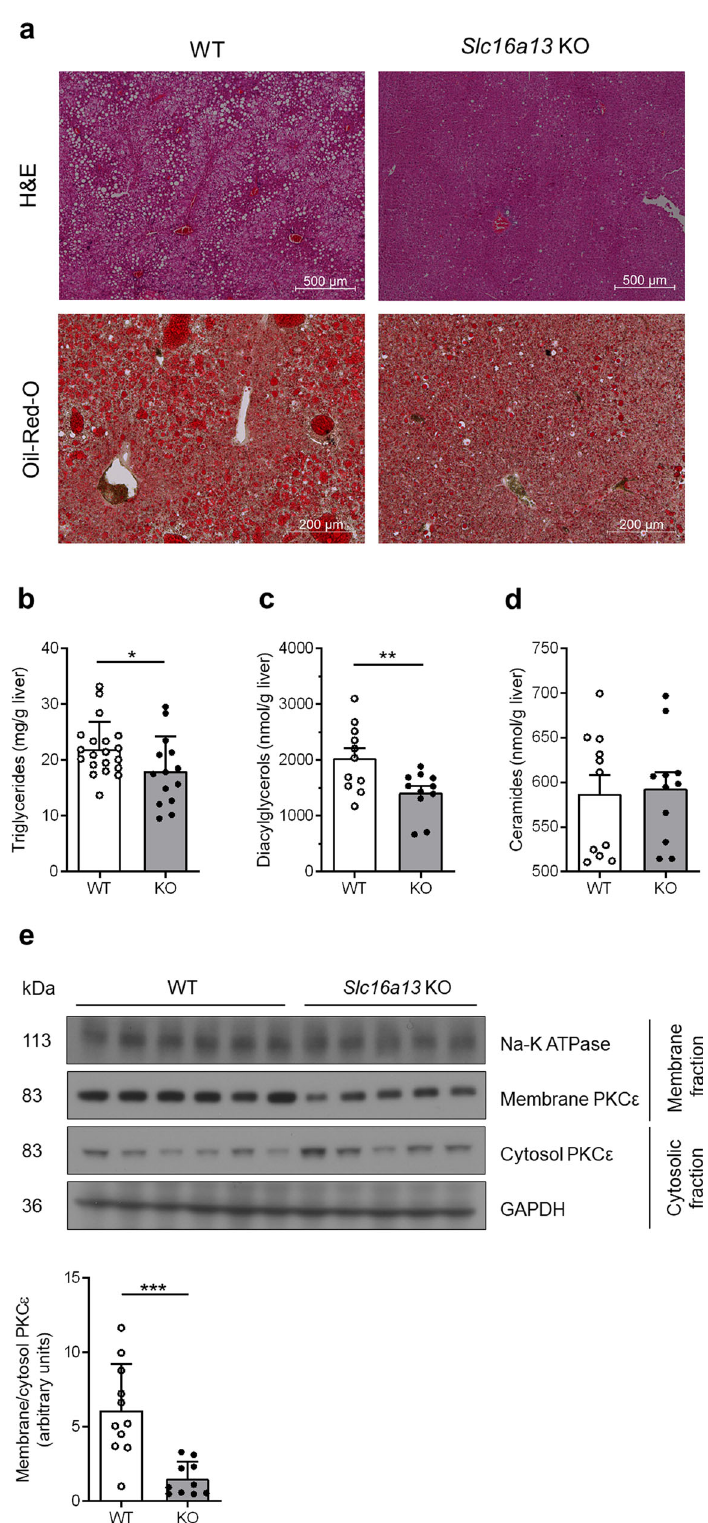
Fig. 7 Liver lipids of Slc16a13 knockout mice at 15 weeks of HFD. a Representative H&E and Oil-Red-O stainings of WT and Slc16a13 KO mice. b Hepatic triglycerides in WT ( n = 20) and Slc16a13 KO mice ( n = 14). Two cohorts of mice have been analyzed. c , d Hepatic diacylglycerol and ceramide level in WT and Slc16a13 KO mice ( n = 11 each group). e PKC ε protein expression determined by western blot shown for WT ( n = 6) and Slc16a13 KO mice ( n = 5). PKC ε translocation assessed as the ratio of membrane to cytosol PKC ε in WT and Slc16a13 KO mice ( n = 11 each group). Bars represent means ± SEM. ** p < 0.05, ** p < 0.01, *** p < 0.001 determined using two-tailed unpaired Student ’ s t -test.